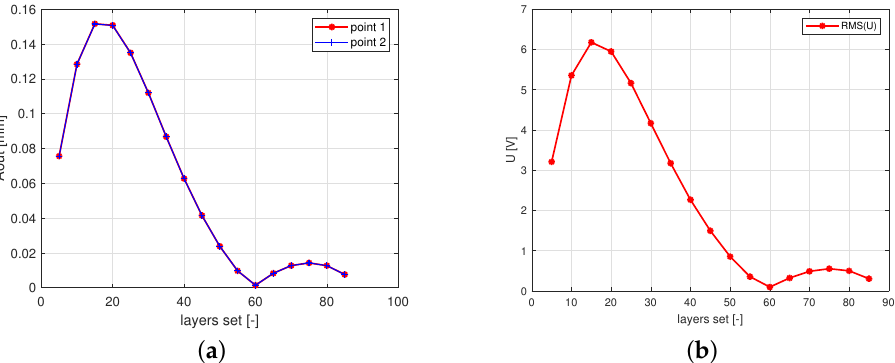
Figure 7. Amplitude response of the antisymmetric beam ( a ), and the root mean square of the electric potential on the piezoelectric patches via fiber configuration sequences ( b